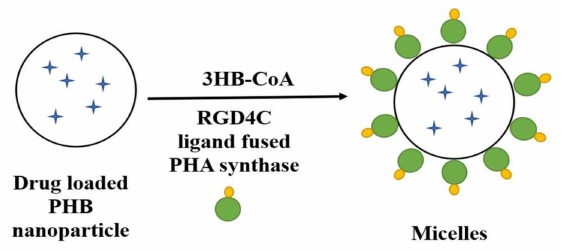
Figure 10. Synthesis of a PHA synthase-based nanoparticle (Inspired from Lee et al.